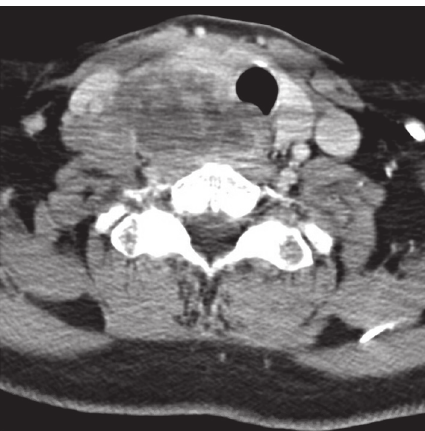
Figure 1: CT scan of the neck at presentation (axial image).